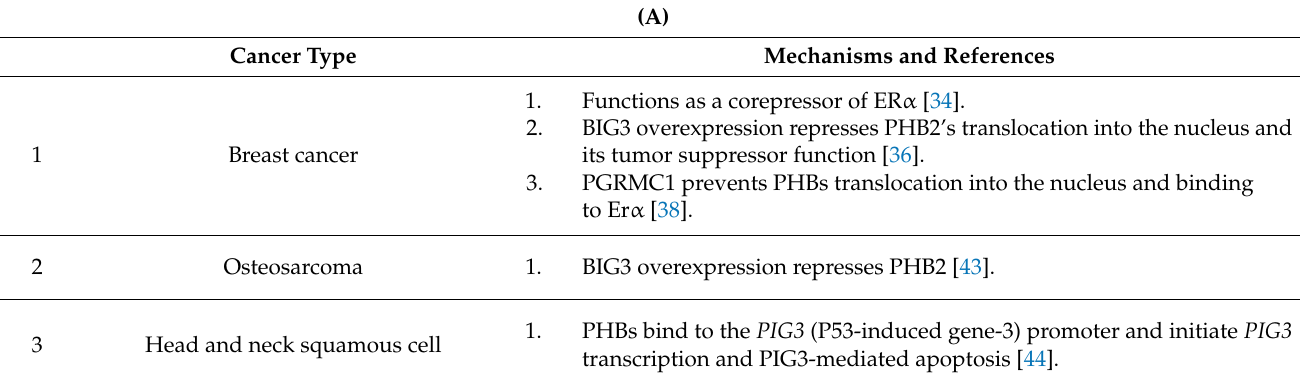
Table 1. ( A ) PHB2 tumor suppressor functions. ( B ) PHB2 oncogenic